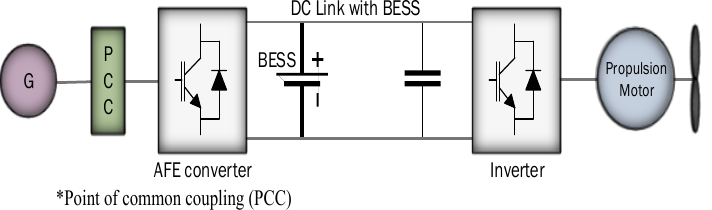
Figure 17. Integration of BESS with integrated power systems